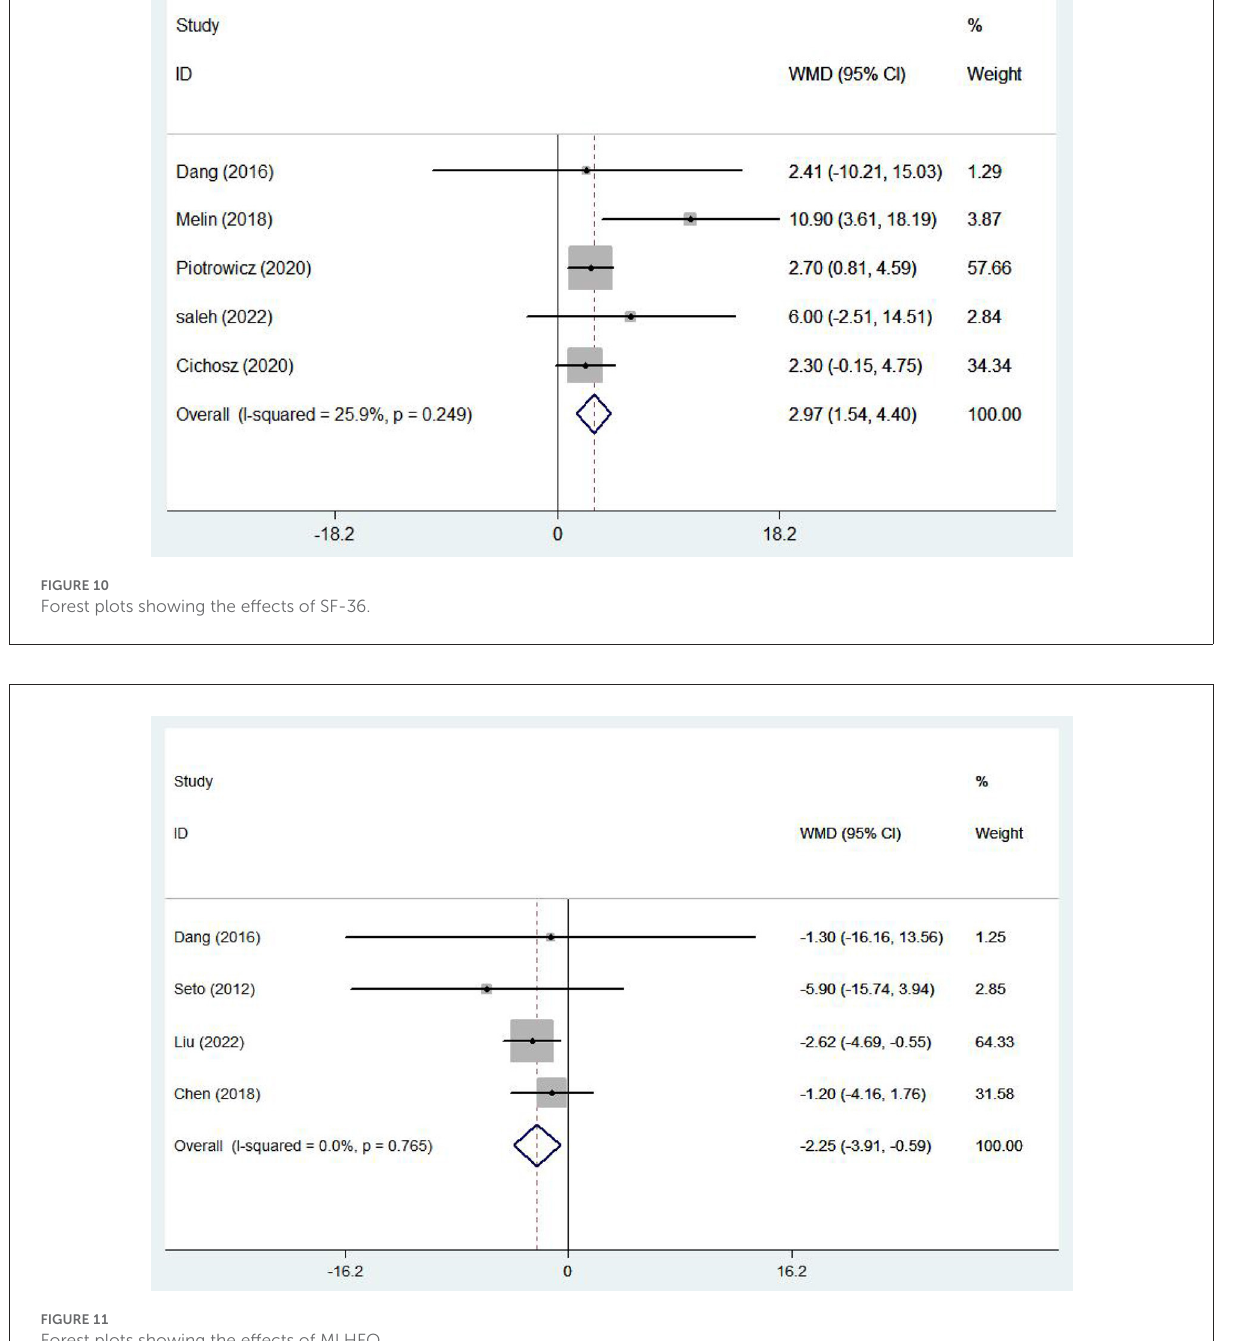
blood pressure and heart rate, fluid intake and observing edema in low hanging areas of the body, and by remote monitoring or professional guidance from health care professionals (32). Also, studies have shown significantly reduced all-cause mortality